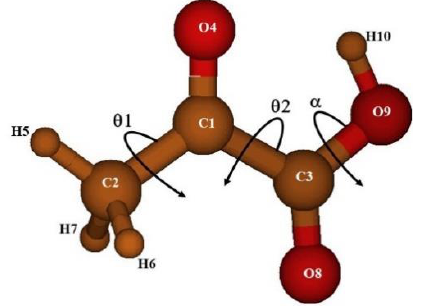
Figure 1. The preferred geometry of pyruvic acid.